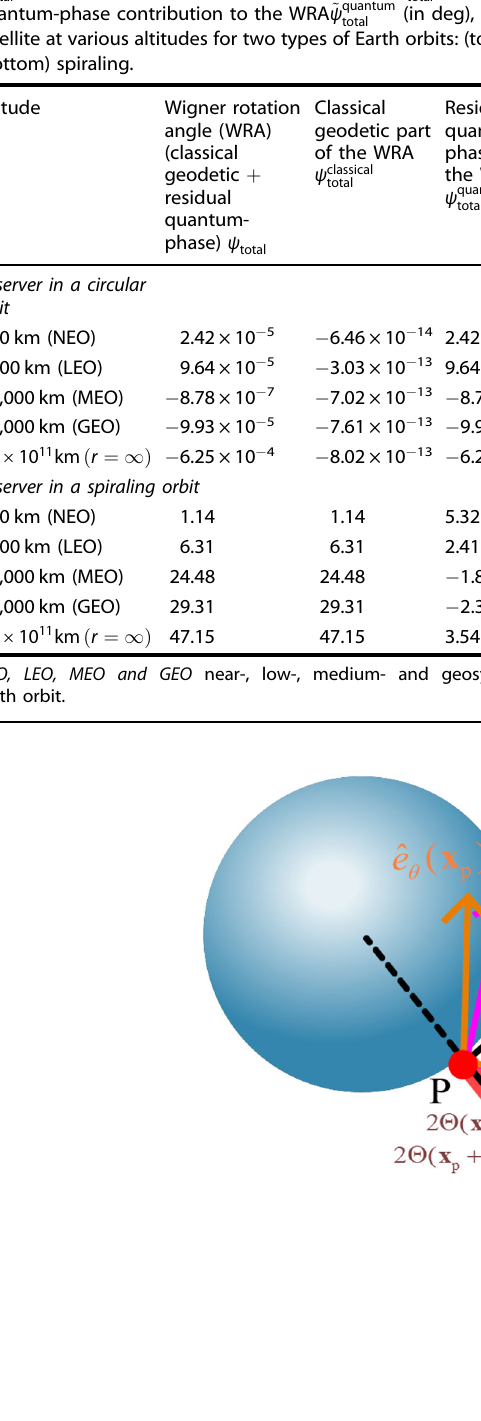
, and residual total (in deg), for a total